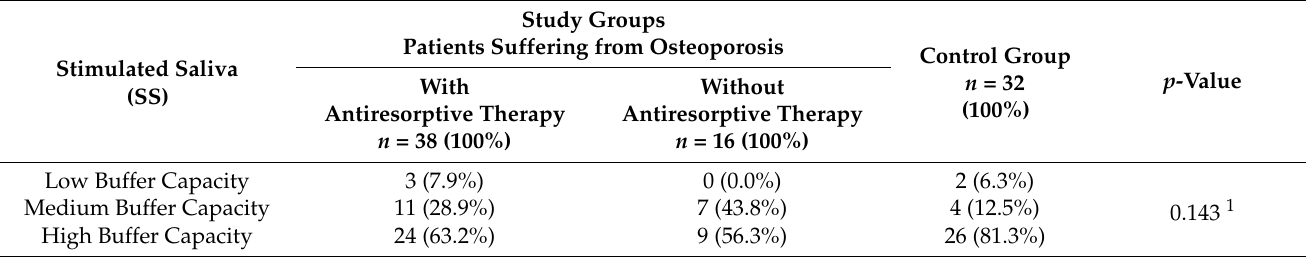
Table 3. Comparison of buffer capacity of stimulated saliva from study groups and the control